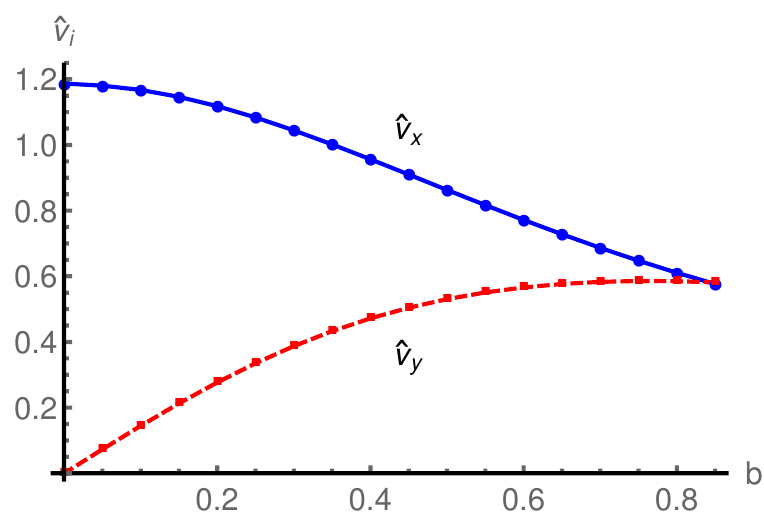
Figure 6 . The sliding speed coefficients ˆ v x (solid blue curve) and ˆ v y (dashed red curve) as functions of magnetic field b for µ = 4 . The curves were extracted directly from the fluctuations of ψ and a y . As a cross-check, the dots were extracted independently from the weights of the delta functions of the optical conductivities. For b > 0 . 864 , the striped phase is no longer thermodynamically stable, and for b > 0 . 95 , no striped solution exists.